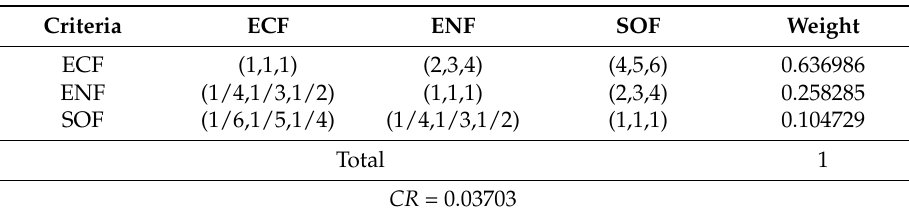
Table A4. Comparison matrix for TRF.